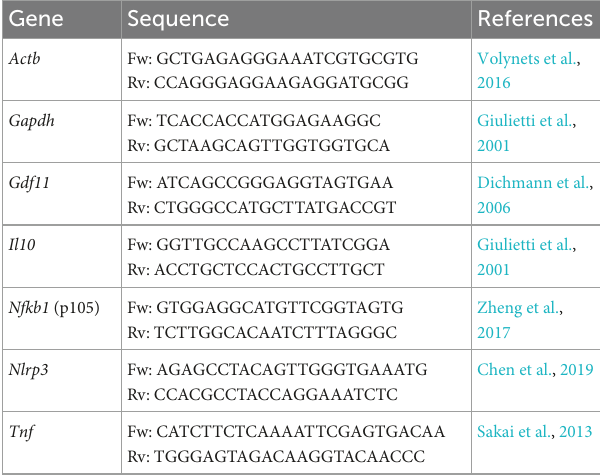
TABLE 2 Oligonucleotides sequences utilized in this study for evaluation of relative gene